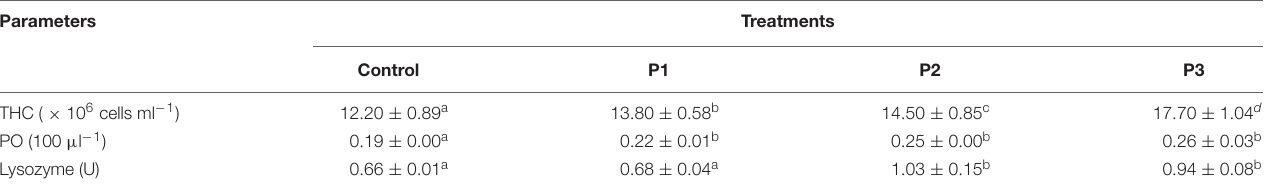
TABLE 3 | Phenoloxidase (PO) and lysozyme activities, and the total hemocyte count (THC) of shrimp in response to feeding different experimental diets.